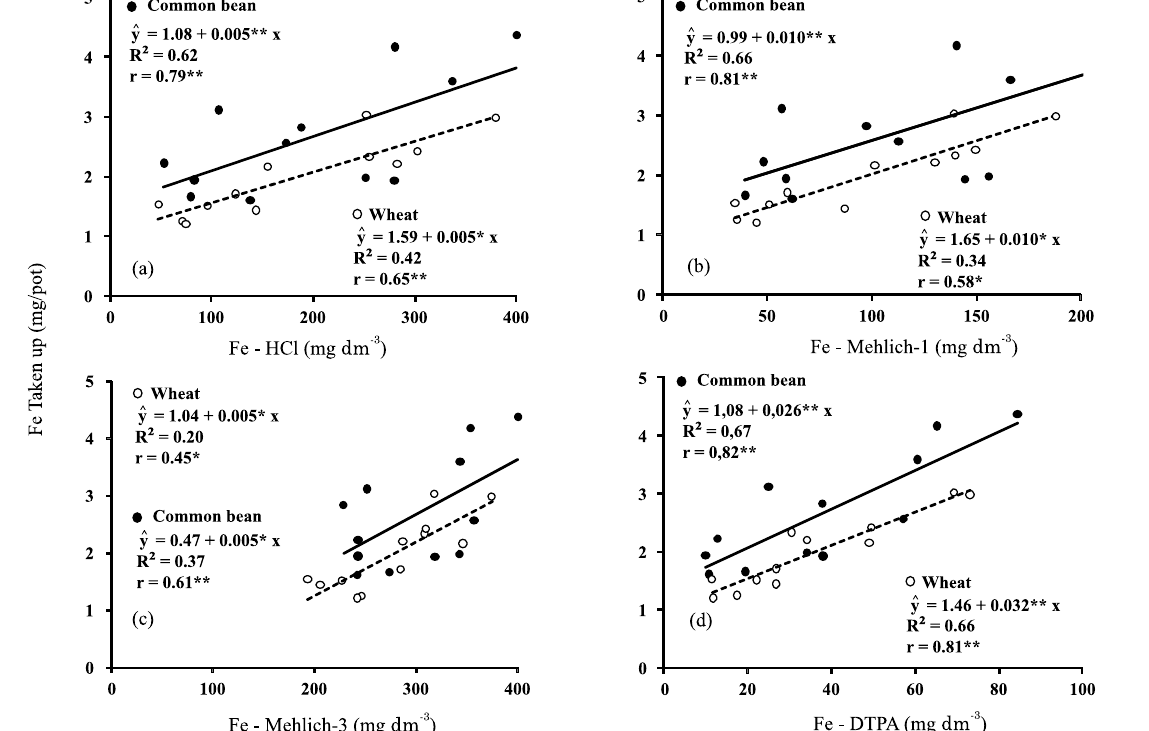
Figure 3. Relationship between the Fe contents extracted from the soil by HCl – (a), Mehlich-1 – (b), Mehlich- 3 – (c) and DTPA (d) and the quantity accumulated in wheat ( ) and common bean ( ) plants, in the first and second planting period, respectively.*: p < 0.05. **: p < 0.01. (n =